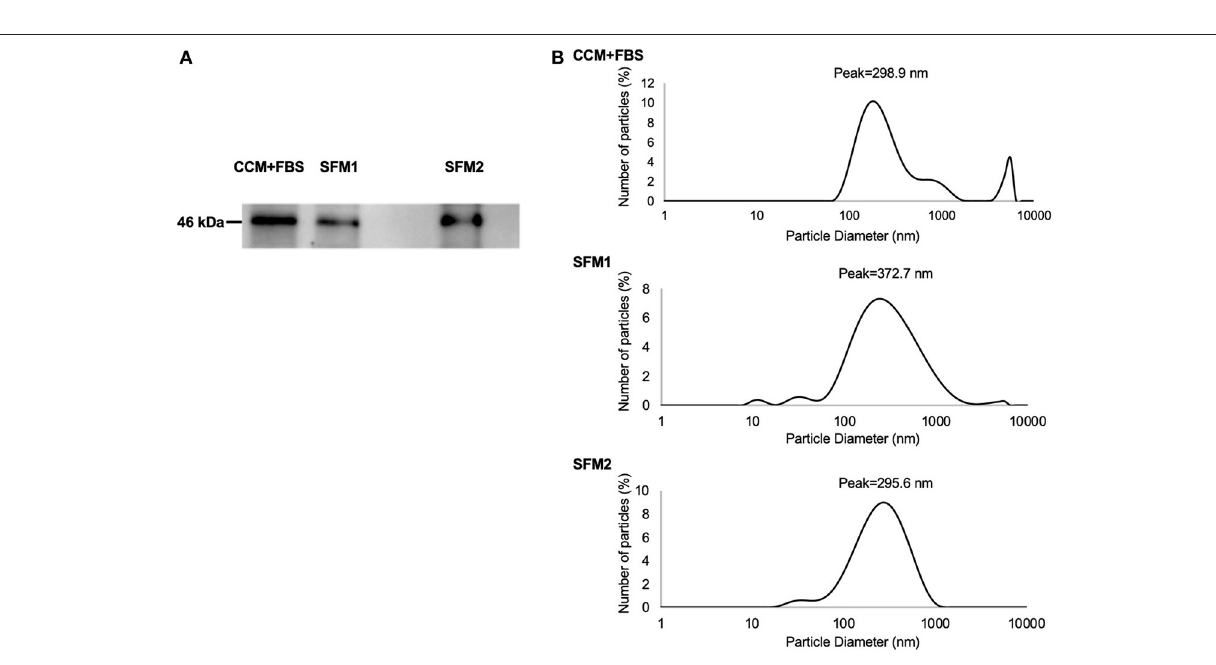
Frontiers in Veterinary Science |